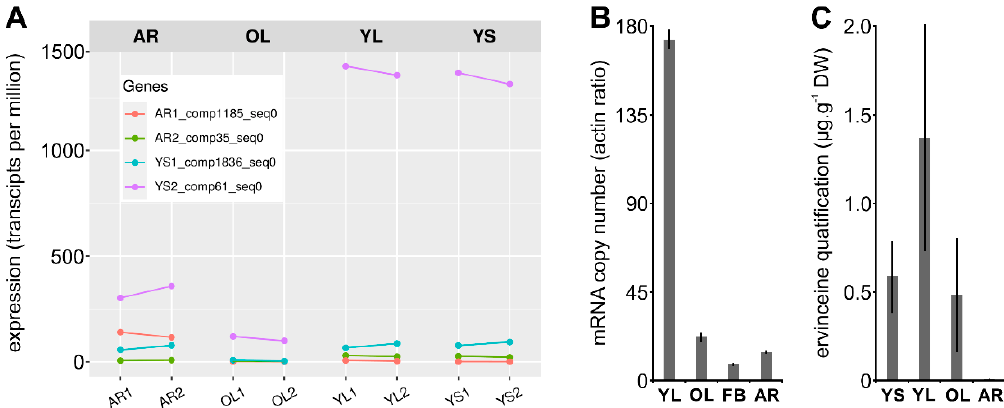
Figure 6. Relative transcript quantification of candidate tabersonine 16- O -methyltransferases and ervinceine amount measurement. ( A ) Relative expression was quantified as transcripts per million (TPM) after mapping RNA-seq reads from young leaves light (YL), young leaves shadow (YS), old leaves light (OL) and adventitious roots (AR) to the consensus transcriptome. ( B ) Relative YS2_comp61_seq0 quantification by reverse transcription quantitative PCR (qPCR) using RNA extracted from young leaves (YL), old leaves (OL), flower bud (FB) and roots (R). Data represents means ± SD of replicates performed on three distinct biological samples of each organ type. ( C ) Ervinceine quantification as µ g / mg (mean ± SD, n = 3) in adventitious roots (AR), old leaves light (OL), young leaves light (YL) and young leaves shadow (YS) performed by UPLC–MS